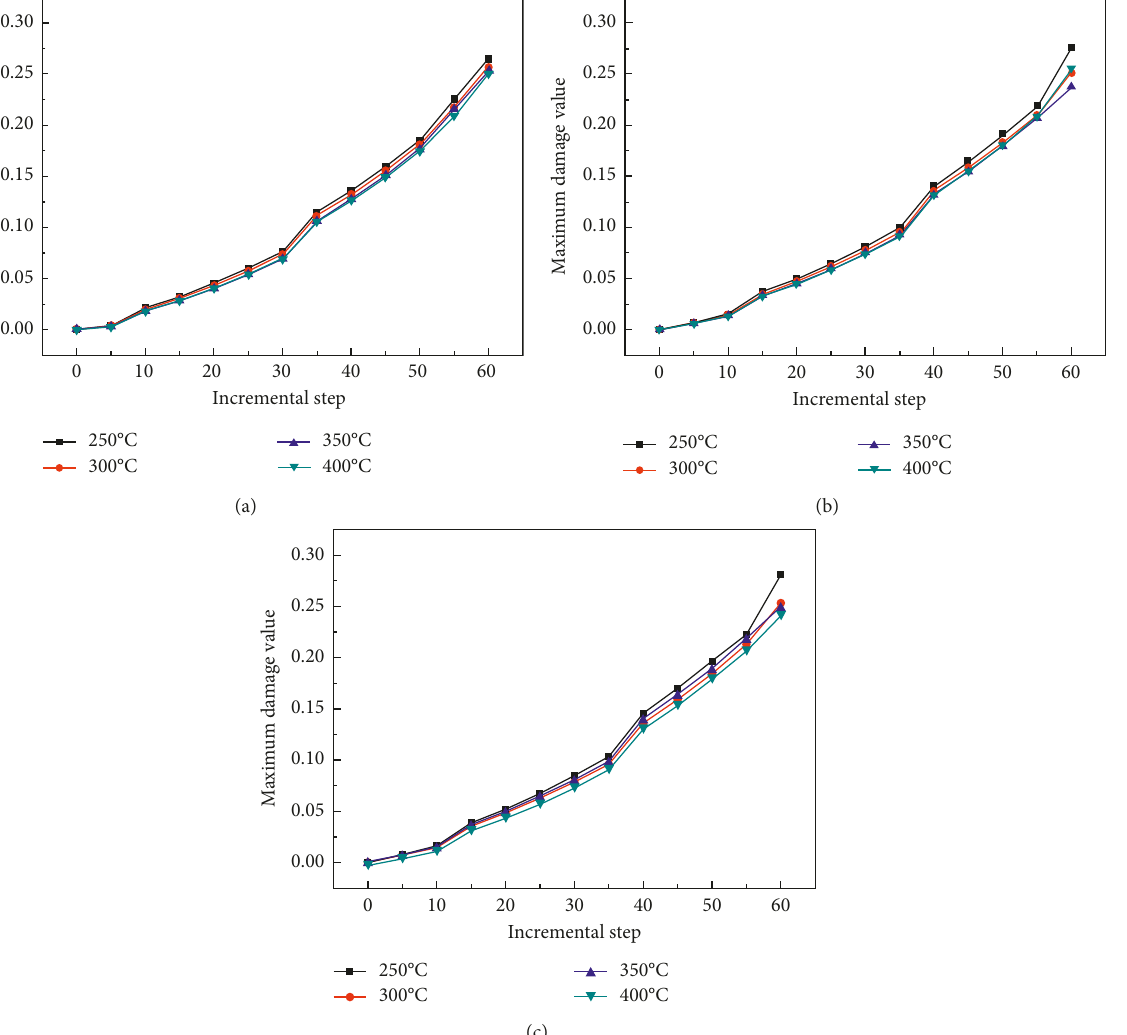
Figure 6: Damage variation on the outer edge of the upsetting drum at different temperatures and strain rates. (a) _ ε